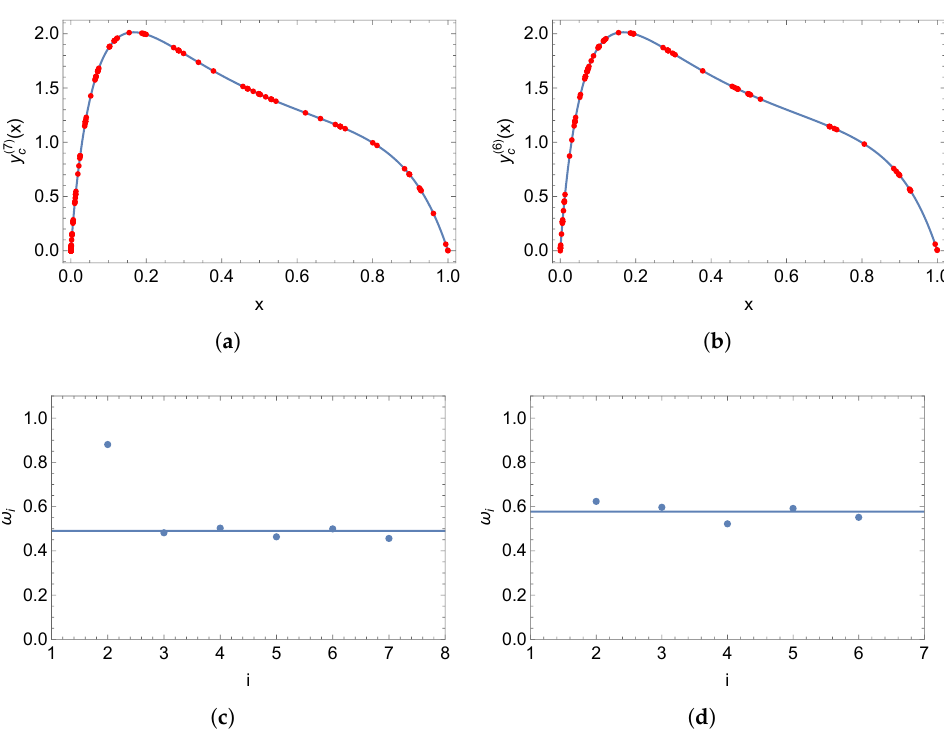
= 2,3, . . . ,7. ( ) ˜ ω ≈ 0.49. ( d ) Plot of i , i i